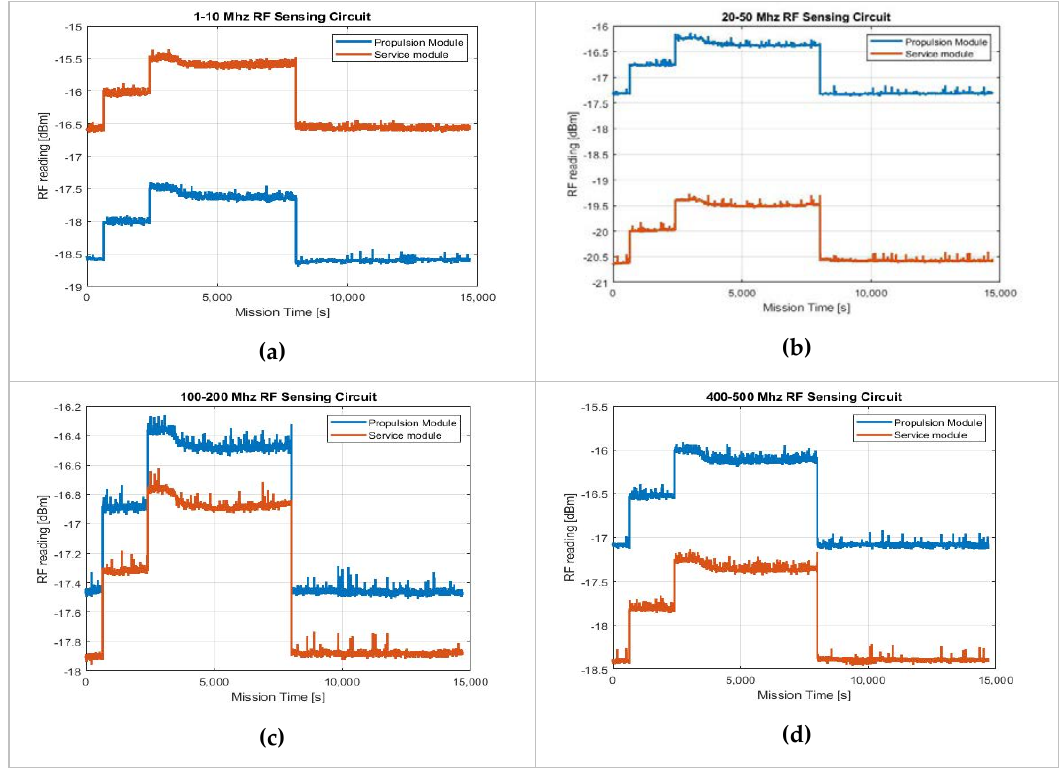
Figure 13. Radiated emissions: ( a ) 1–10 MHz, ( b ) 20–50 MHz, ( c ) 100–200 MHz, ( d ) 400–500 MHz.